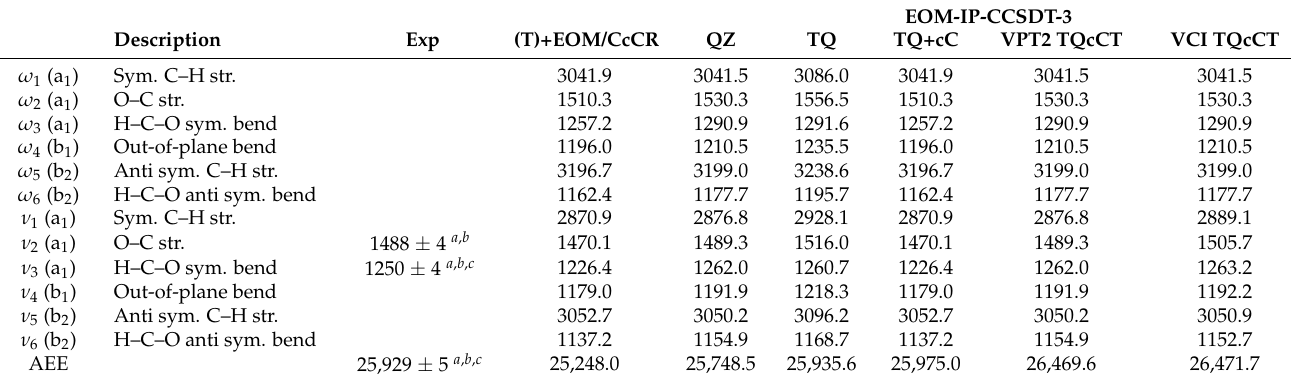
Table 9. Ã 2 B 1 H 2 CO + Vibrational Frequencies in cm − 1